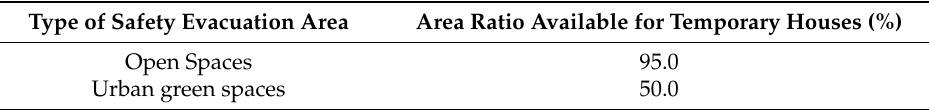
Table 1. Area ratio available for temporary houses of safety evacuation